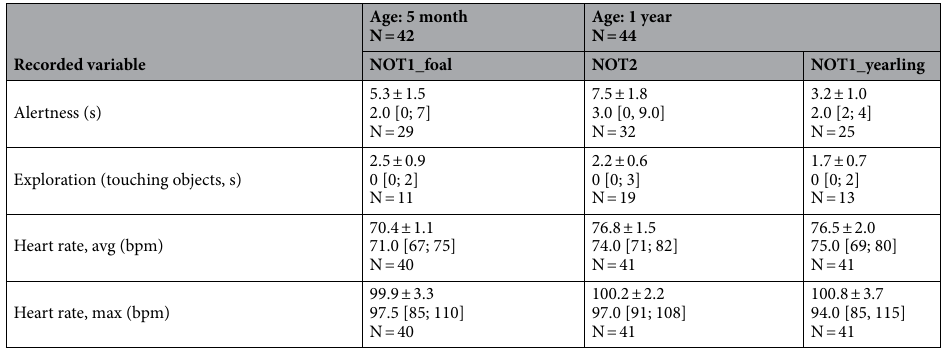
Table 1. Behaviour and heart rates (mean ± s.e.m. and median [25%; 75%]) in the Novel Object Tests at 5 months (NOT1_foal) and at 1 year of age (NOT2, and re-exposure to the NOT1 objects: NOT1_yearling). N denotes the number of horses showing the behaviour or with usable heart rate files. See “Methods” section for description of tests and recordings.